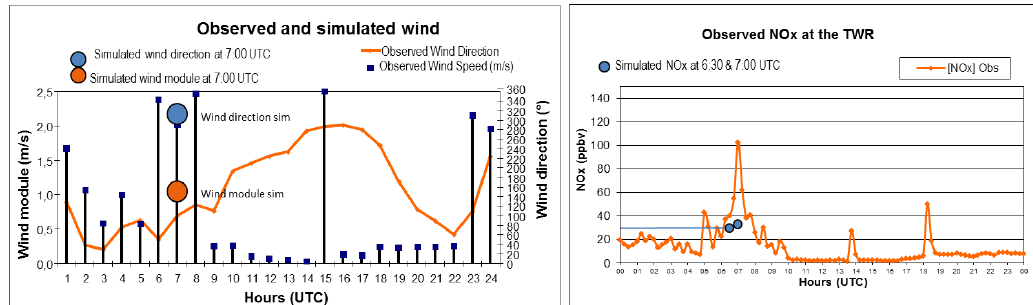
Figure 4. Observed wind time series (module and direction) and comparisons with the simulation output at 7:00 UTC (orange and blue circles) and observed NO x concentration time series with simulated NO x at 6:30 and 7:00 UTC. TWR: control tower.